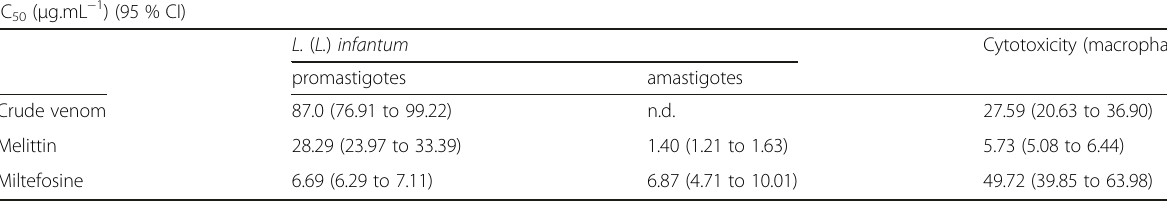
Table 1 Antileishmanial and mammalian cytotoxicity of whole venom and melittin IC 50 ( μ g.mL − 1 ) (95 %